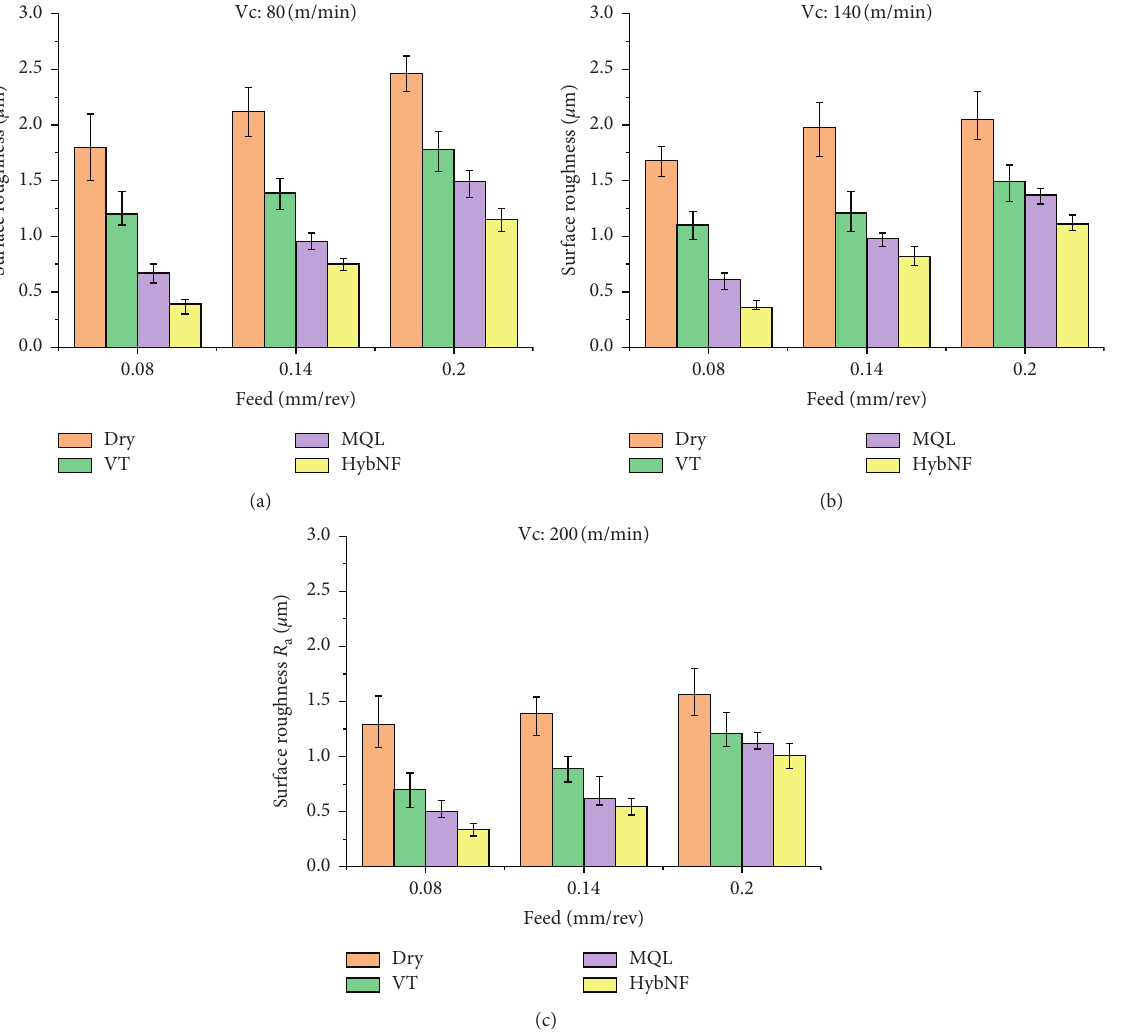
Figure 5: Effect of feed (f mm/rev) on surface roughness ( R 200m/min cutting